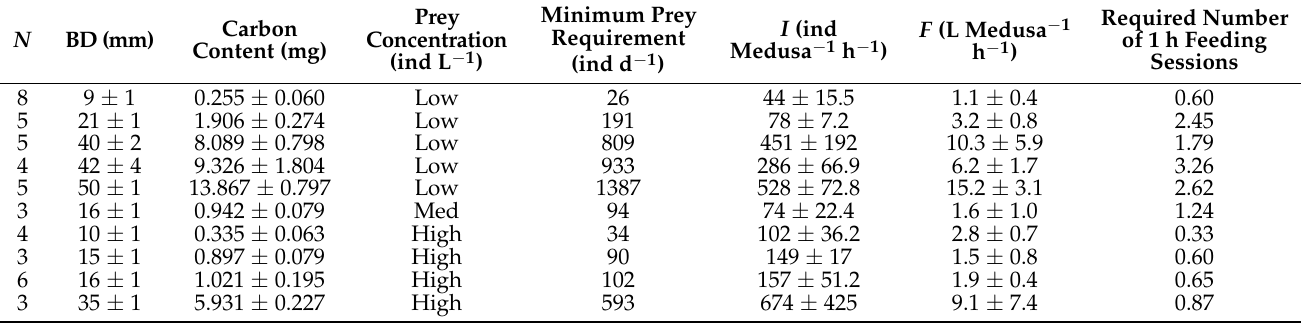
Table 5. Feeding trial